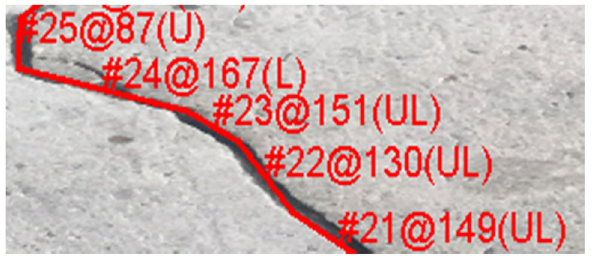
Figure 7. Example of a traced crack with the relevant information to be saved in a